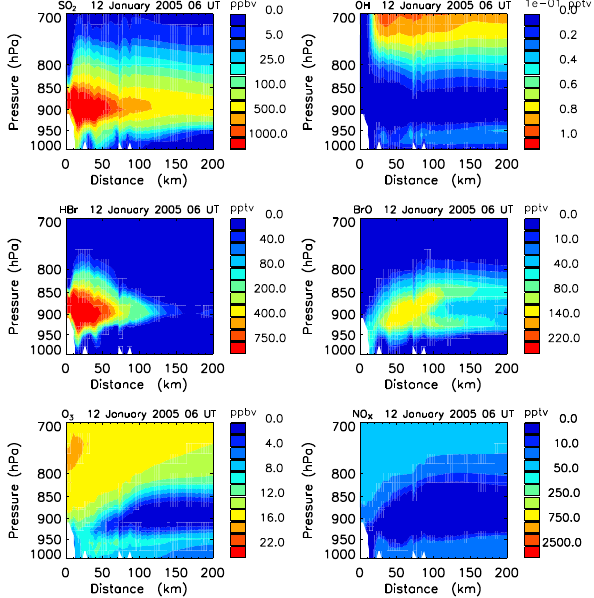
Figure 6. Distance–pressure cross section of the SO 2 , OH, HBr, BrO, O 3 and NO x mixing ratios in the plume of Ambrym on 12 Jan- uary 2005 at 06:00UTC in the simulation